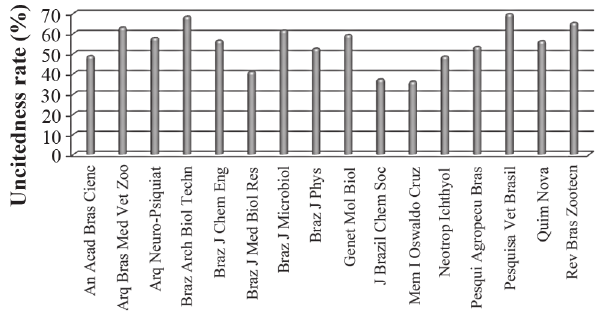
Fig. 4. Uncitedness rate of articles published in the Brazilian journals in Sample